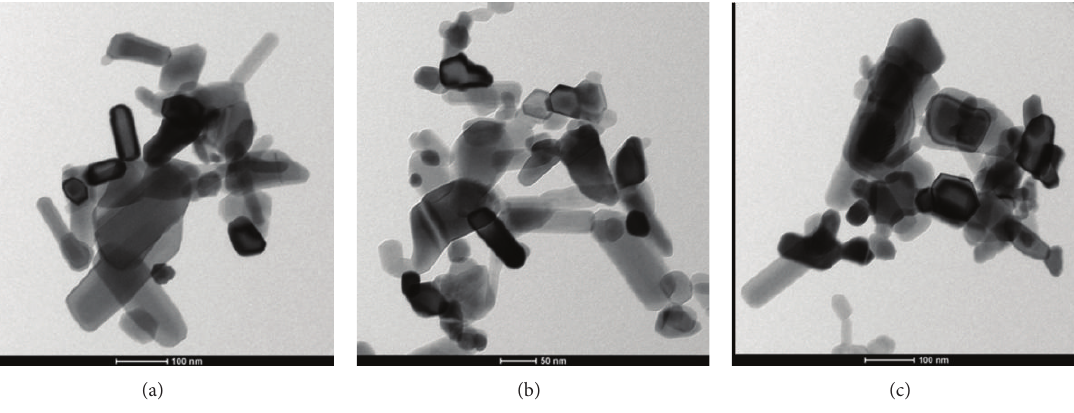
Figure 3: TEM images of the nano-ZnO.